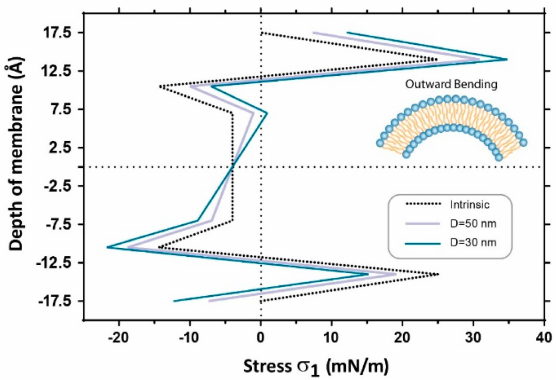
Figure 8. Change in the pressure profile along the membrane thickness due to the application of two levels of local curvature (Outward bending). This is equivalent to the curvature seen upon PLC activation, which cleaves PIP2 in the inner bilayer leaflet to produce diacylglycerol (DAG), which in turn can change local curvature of the membrane. This curvature also mimics the addition of lysophosphatidylcholine (LPC) or a similar shaped lipid into the outer leaflet. The opposite is true for negative curvature in this